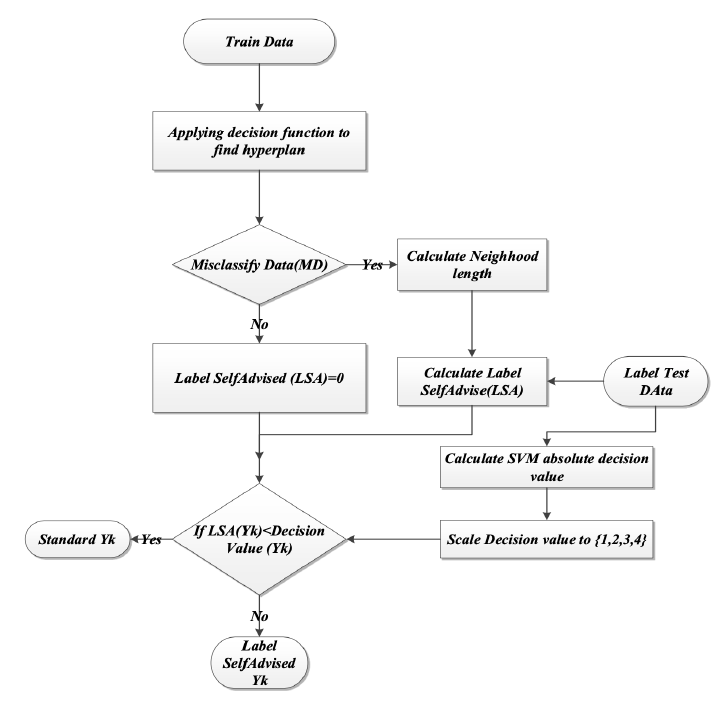
Figure 11. Flowchart of the LSA-SVM methods steps.